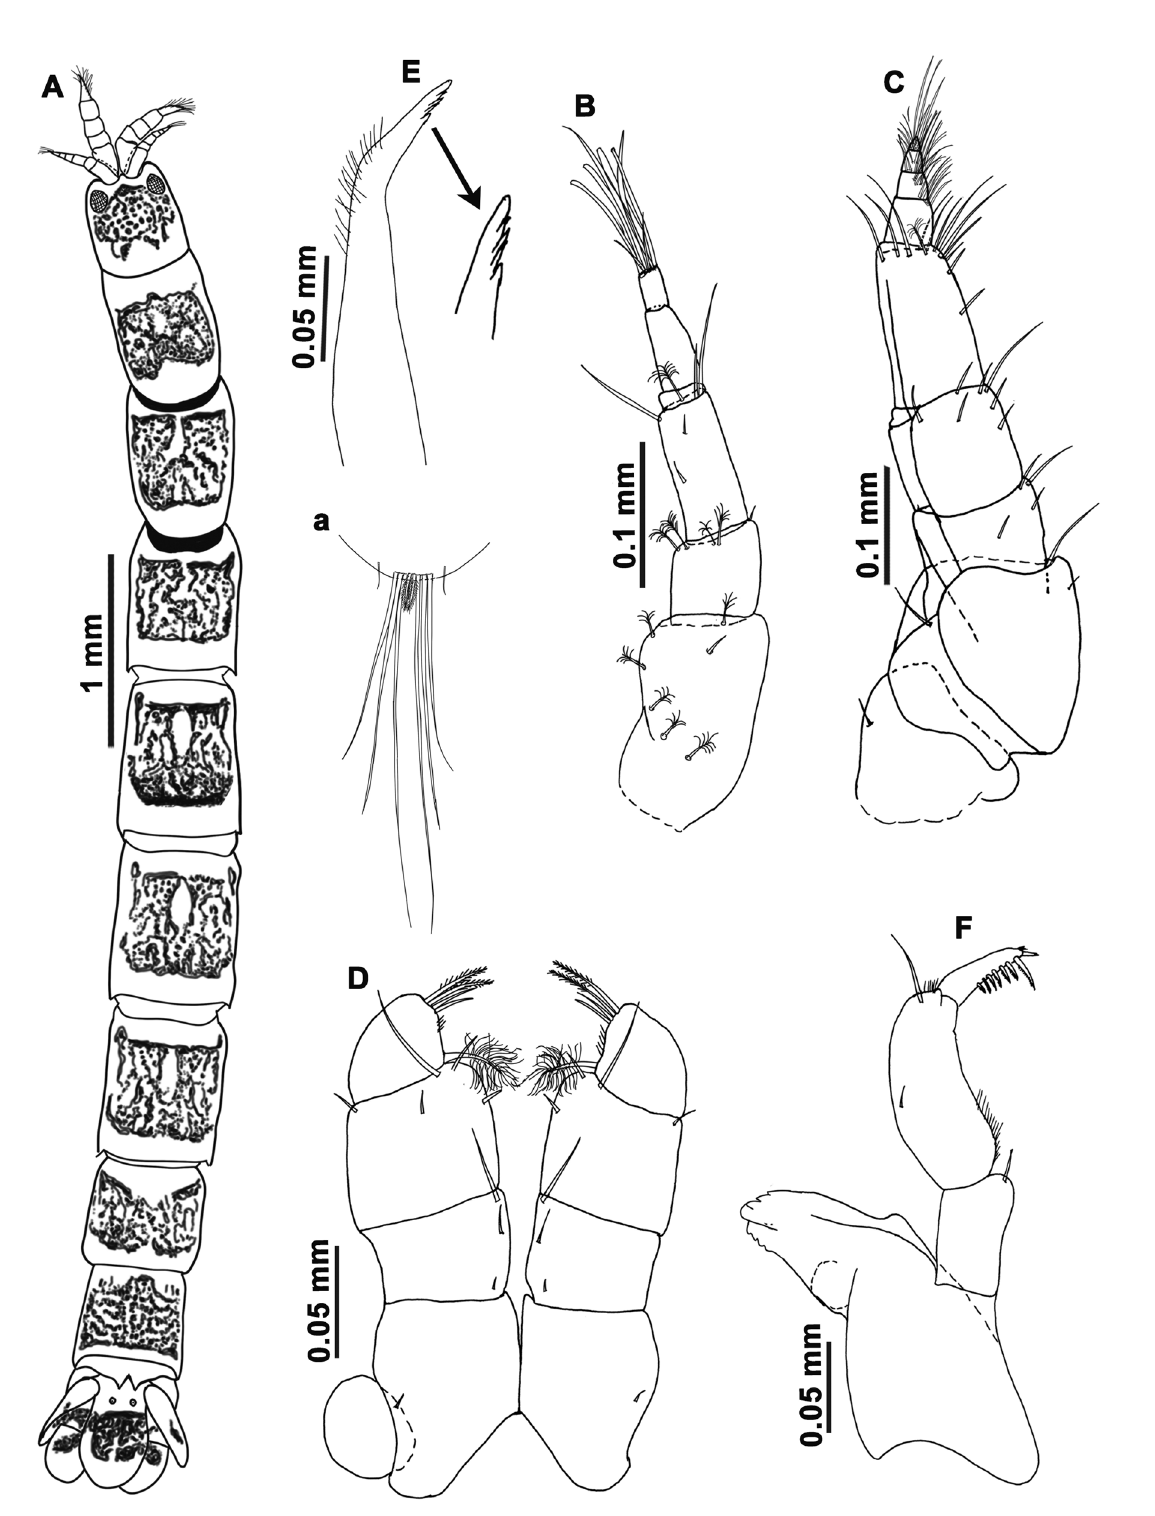
Fig. 11. Mesanthura estacahuitensis sp. nov., holotype, ♀, 6.8 mm, Oaxaca, Puerto Ángel, Estacahuite Beach (UMAR-PERA 547). A . Habitus and detail of the telson (a). B . Antennule. C . Antenna. D . Maxilliped. E . Maxilla and detail of the distal teeth. F .